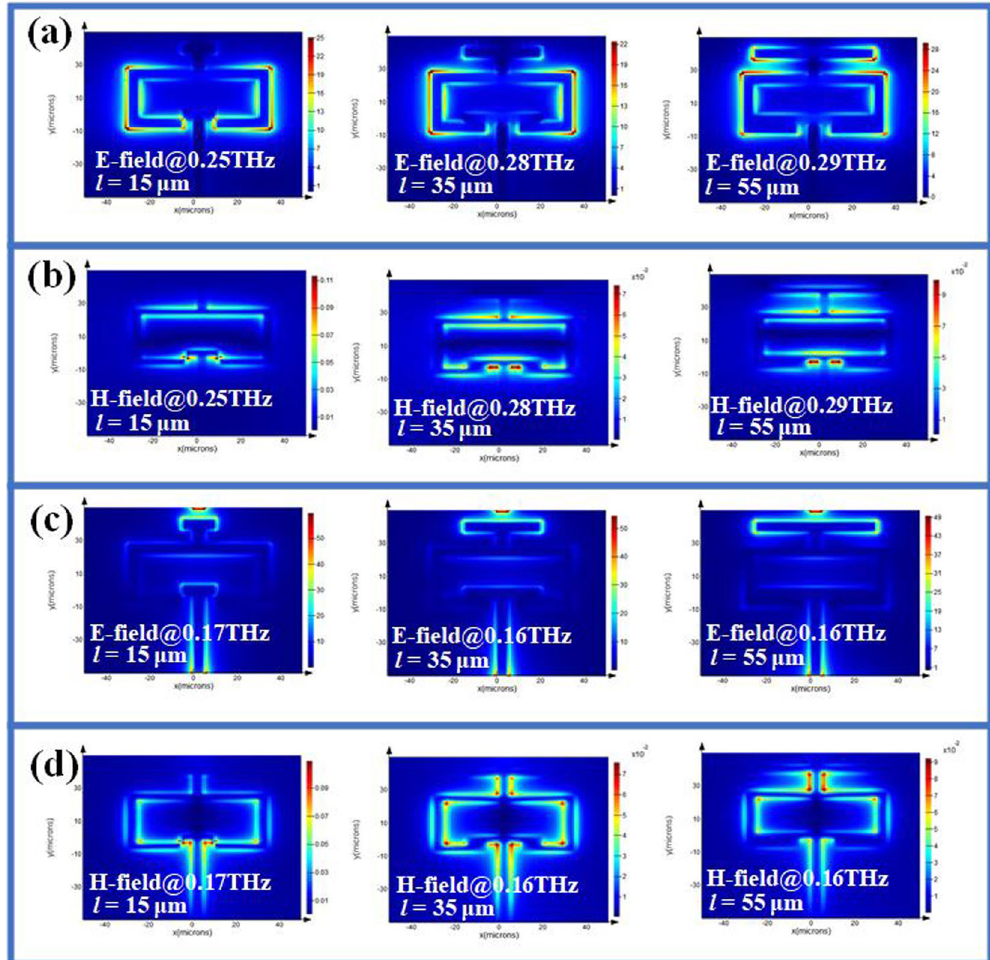
Figure 5. Electromagnetic field distributions of CLM with different l value. Electromagnetic field distributed images of CLM with different l value at ( a ) and ( b ) TE mode, ( c ) and ( d ) TM mode, where ( a ) and ( c ) are E-field distributions, while ( b ) and ( d ) are H-field distributions. (Symbol @ indicates the corresponding monitored